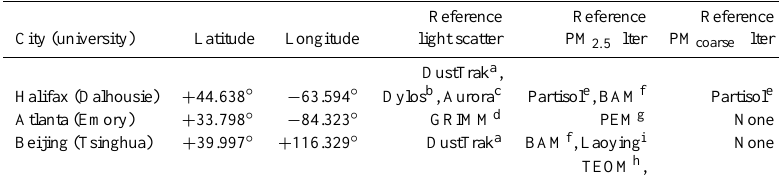
Table A2. Site locations of SPARTAN monitors and the collocated reference instruments for pilot study.